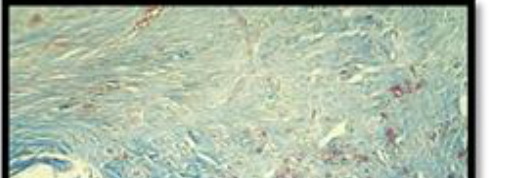
Figure, 13: UBM-treatment group at 2nd week post implantation, shows vascular granulation tissue was infiltrated with MNCs and myofibroblasts extended from muscular borders of implantation site (H &E stain, 400).